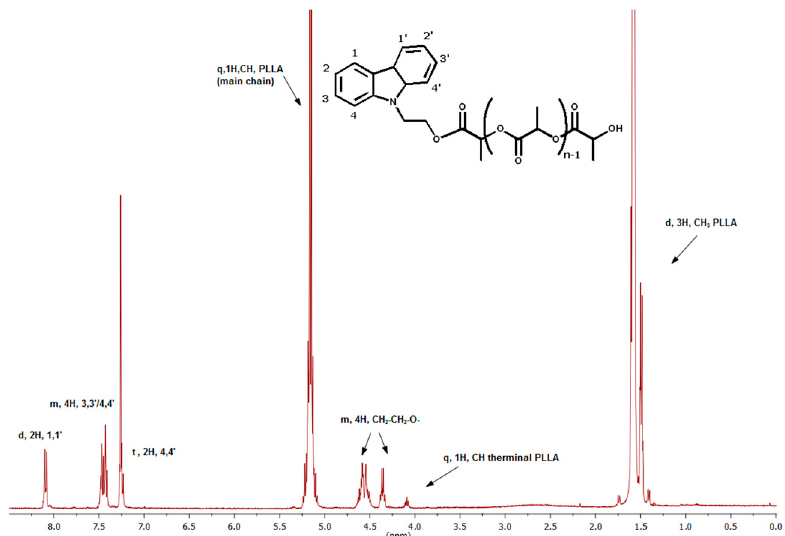
Figure 2. Proton nuclear magnetic resonance 1 H-NMR spectrum of macromolecular dye (MD) prepared